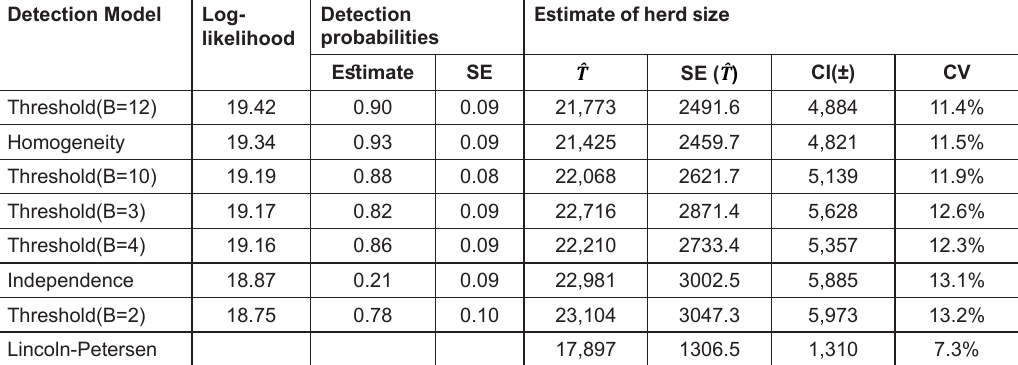
Table 14. Rivest estimator results and LP estimate for the Bluenose-West 2009 data set. Detection Model